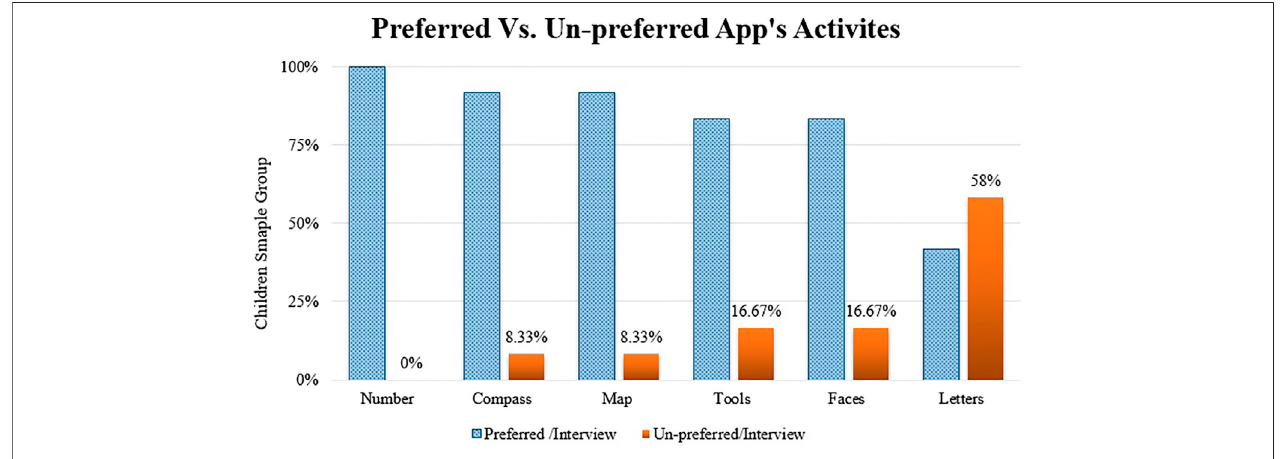
FIGURE 5 | Preferred and unpreferred app ’ s activities according to the children ’ s responses on the interview-based